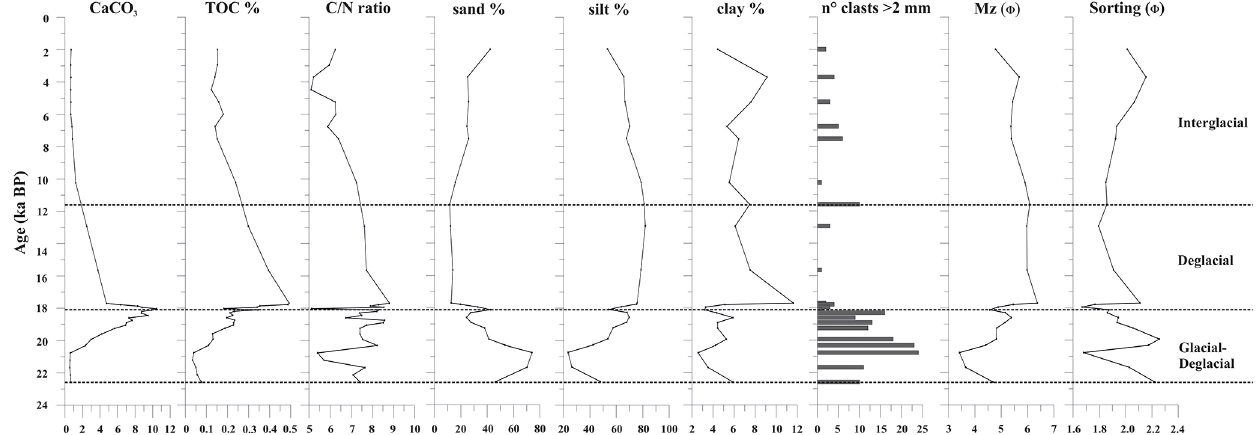
Figure 3. Sediment geochemistry and texture of the studied core. From left to right: down-core distribution of CaCO 3 (%), organic carbon (%), C org /N tot content, sand (%), silt (%), clay (%), number of clasts > 2mm in size, mean diameter ( M z ), and sorting in (cid:56) . The top level of this core dates to 2.0ka.